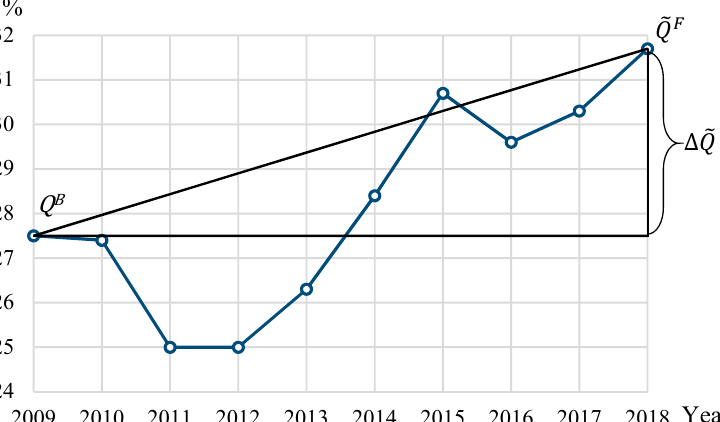
Figure 5. Energy development in the Lithuanian transport sector over the 2009–2018 period (source: compiled by the authors).